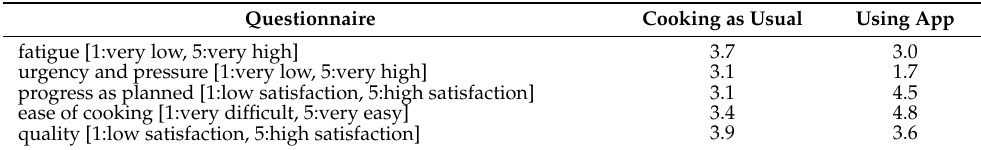
Table 7. Questionnaire results on cooking and app.